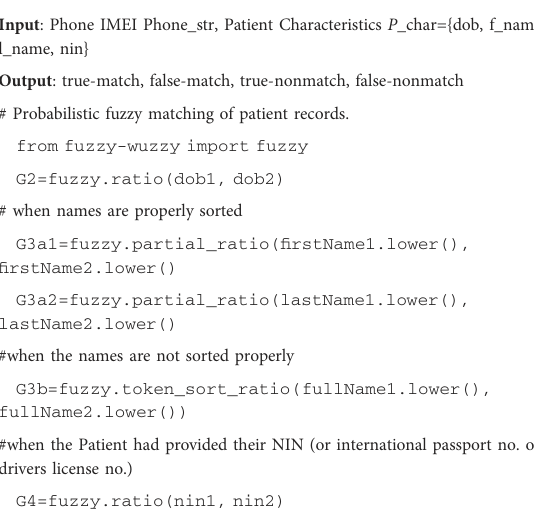
Algorithm 2: Probabilistic fuzzy matching records